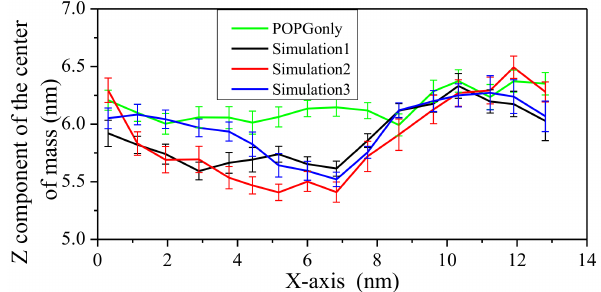
Figure 7. The z component of the center of mass coordinates of upper phosphorus atoms of POPG bilayer for last 5-ns-length trajectories. The upper phosphorus atoms of POPG were divided into 16 bins according to their x-axis positions. The abscissa is the average x-axis position of upper phosphorus atoms for each bin. Simulations 1, 2, and 3 correspond to three independent simulations. The results for POPG in the absence of LL-37 are also shown in